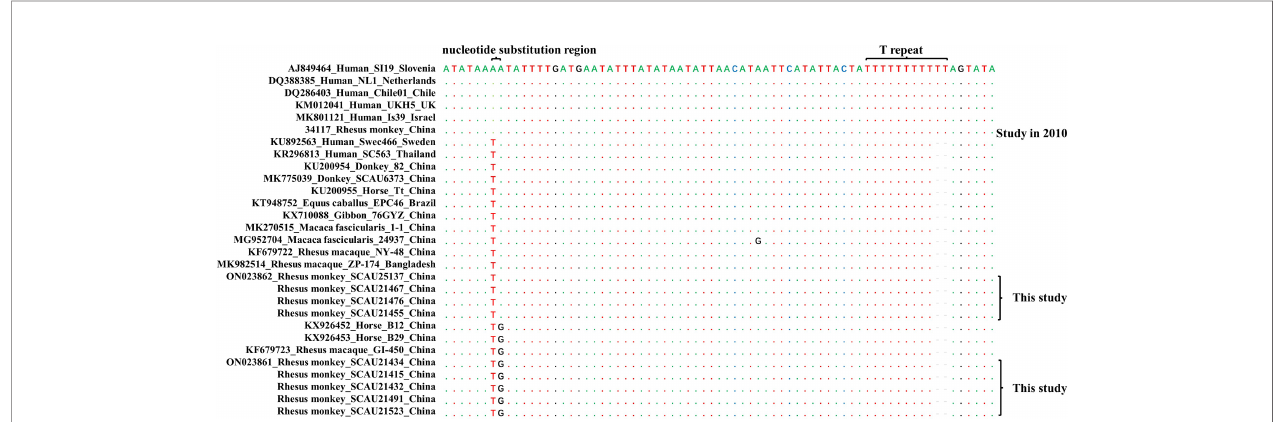
FIGURE 1 | Sequences of hypervariable region of the small subunit rRNA gene among Cryptosporidium hominis isolates from various hosts. Compared with the reference sequence AJ849464 (Soba et al., 2006), identical nucleotides and nucleotide deletions are present as dots and cashes, respectively. The two regions with nucleotide substitutions and differences in the number of consecutive T are labeled. Sequences from this and previous studies are indicated. In this study, all samples used in the analysis are from monkey